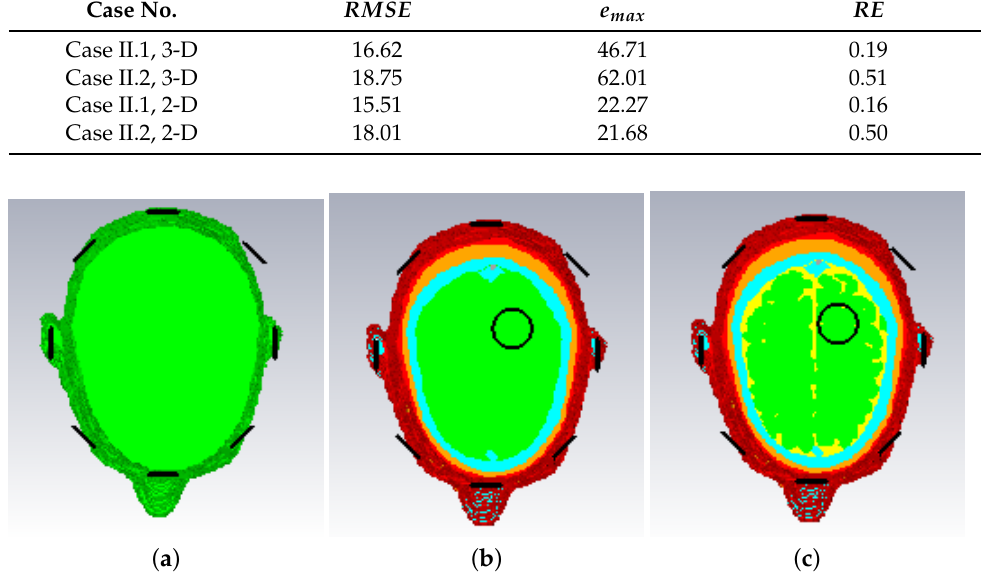
Figure 10. Cross-sectional view of models for “Case II.1” and “Case II.2”: ( a ) the NT model for both cases; ( b ) WT1 model for “Case II.1” where gray matter and CSF are replaced by white matter; ( c ) WT2 model for “Case II.2” where gray matter only is replaced by white